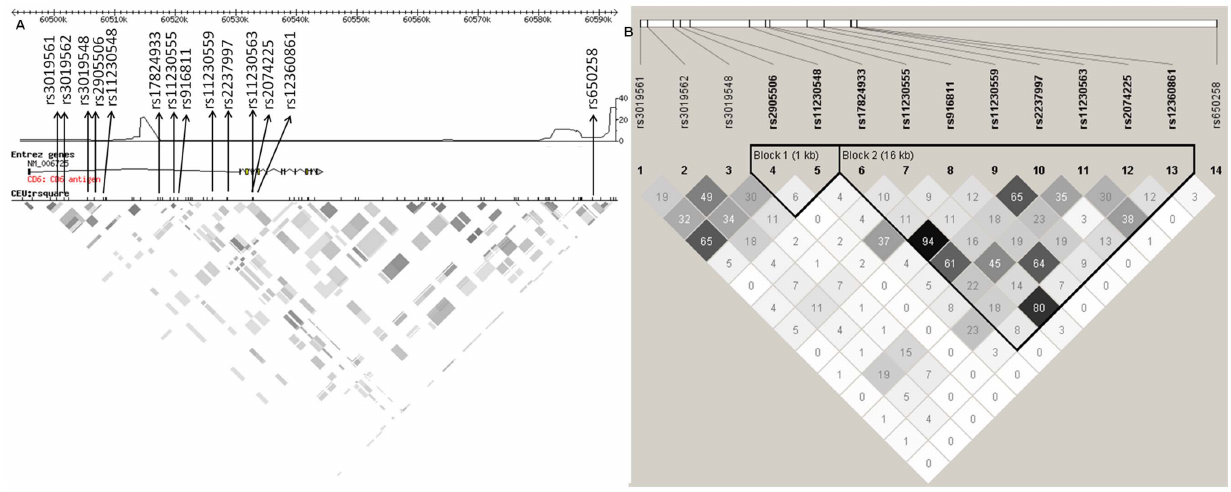
Figure 1. Locations of the 14 Stage 1 SNPs and their linkage disequilibrium (LD) patterns at the CD6 locus. (A) LD block images with the approximate locations of the 14 SNP markers chosen for this study, recombination spots and LD patterns within the CEU LD plot (Hapmap, version 27) of the CD6 gene, and (B) LD patterns in the northern Spanish-Basque population using the confidence interval method (Gabriel et al. [54]; generated using the Haploview software).